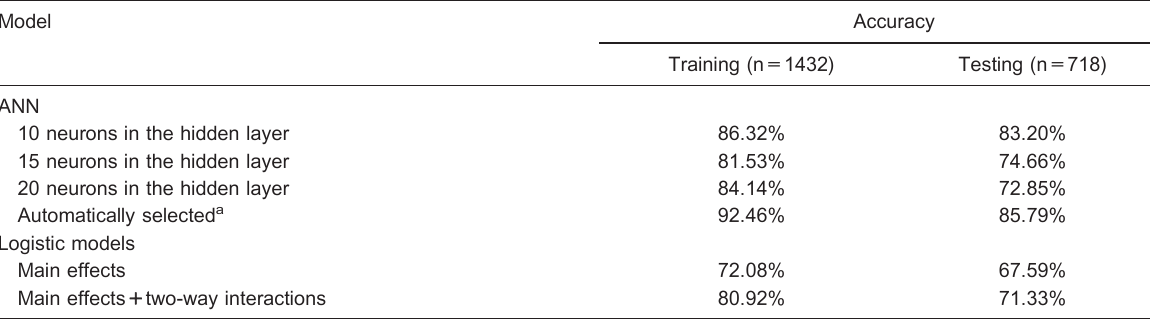
Table 2. Accuracies of artificial neural network (ANN) models and logistic